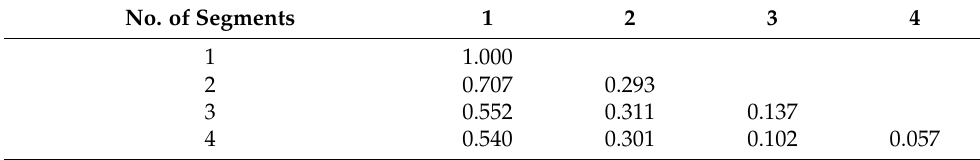
Table 5. Relative segment